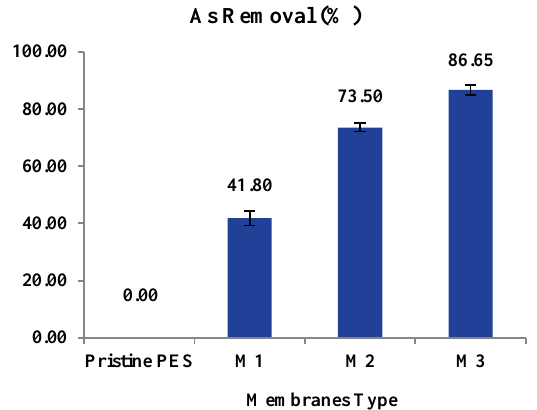
Figure 6. Arsenate rejection of the graphene oxide-coated membranes. operating pressures =